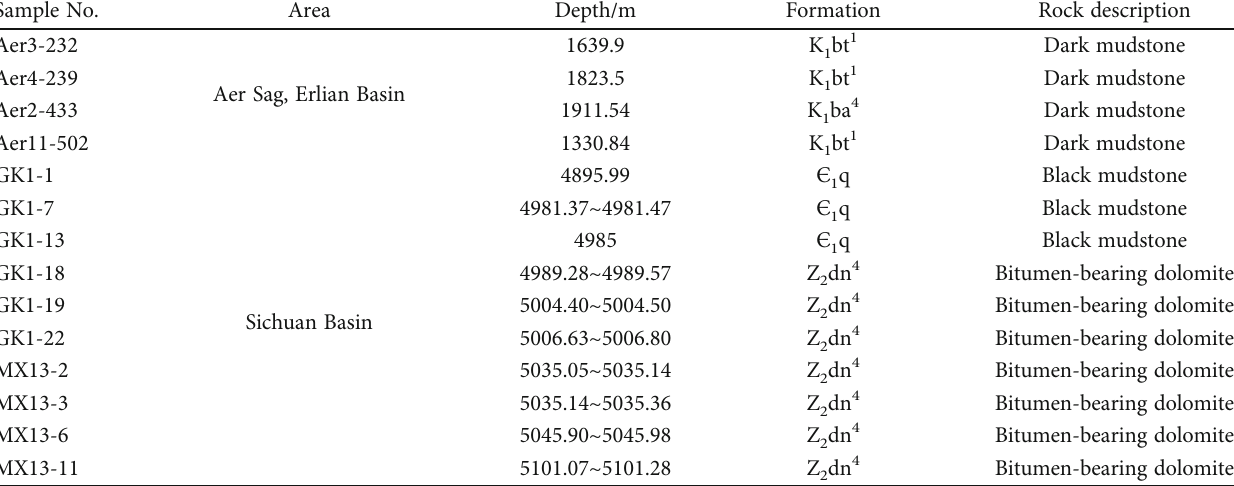
Table 1: Basic information of mudstone samples in the study (sample number consisted of well name and original sampling number. See Figure 1 for the location of the wells). Sample